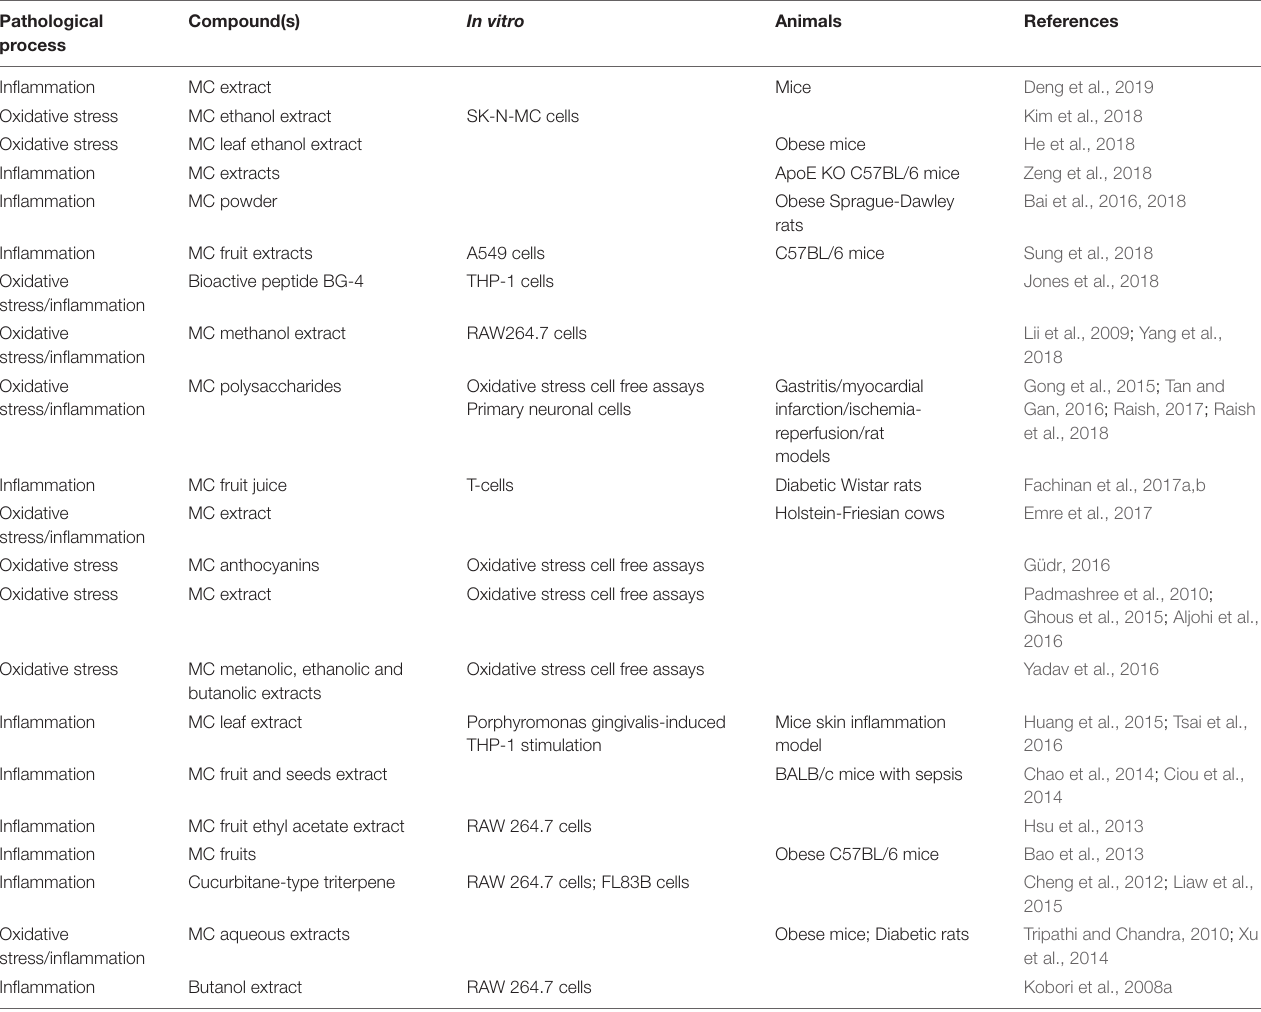
TABLE 1 | Main anti-oxidant and anti-inflammatory studies carried out in vitro and in vivo with MC components. Pathological